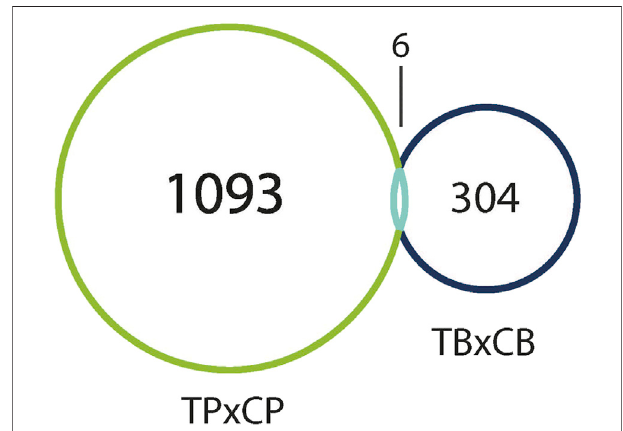
FIGURE 5 | Venn diagram of DEGs (both up- and downregulated) in TCDD-exposed pseudo bulk-seq preparation (left), and bulk-seq preparation (right) as compared to control. Pseudo bulk-seq detected 1,093 DEGs that were undetected in bulk-seq. Conversely, 304 genes were detected using bulk-seq, but not pseudo bulk-seq. 6 DEGs were detected by both